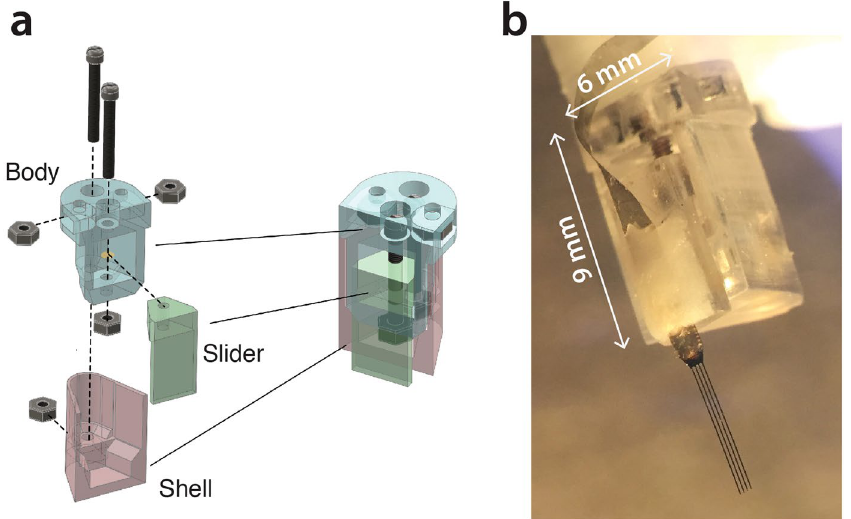
Figure 2. Micro-drive for convenient electrode recovery. ( a ) The slider (green) is held embedded in the body (blue) by the front screw and moves vertically when the screw is turned. The body is held embedded in the shell (red) by the back screw. The shell is the part that is cemented to the animal ′ s head. The probe and micro-drive can be recovered by unscrewing the body from the shell. A new shell should be printed and attached before the probe is re-used. ( b ) Picture of the micro-drive with a silicon probe cemented to the slider. The micro-drive is fixed to the handle.